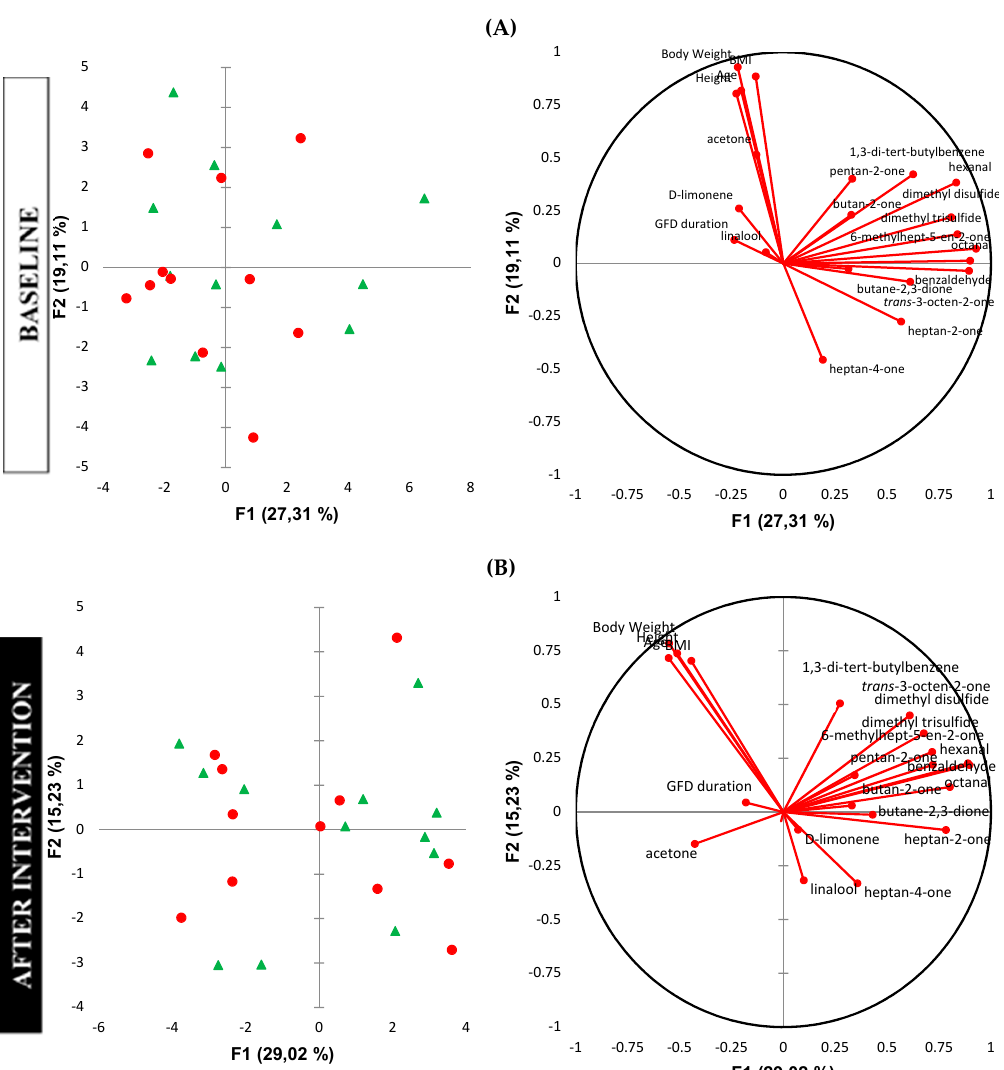
Figure 2. Results of principal component analysis (PCA) of urinary VOCs at baseline ( A ), and after the intervention ( B ). Red circles—Synergy 1 group; green triangles—placebo group. Left graphs— score plot; right graphs—correlation circle presenting correlations between individual VOCs and anthropometric indices.